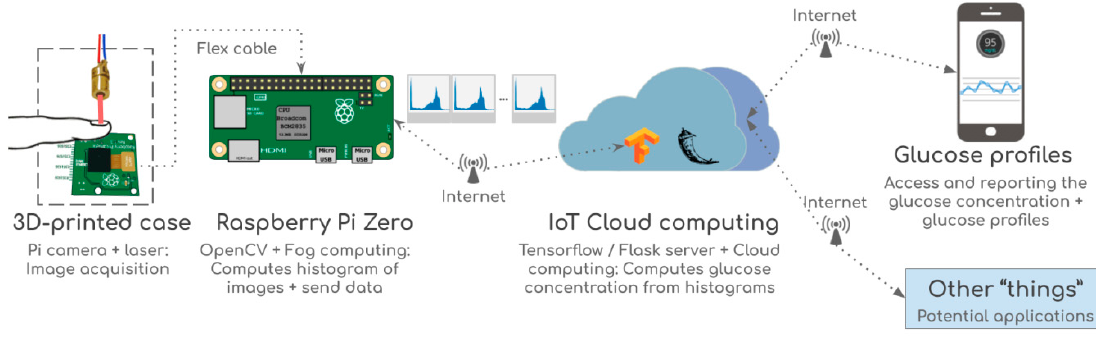
Figure 1. Diagram of the proposed Internet of Things (IoT) system.